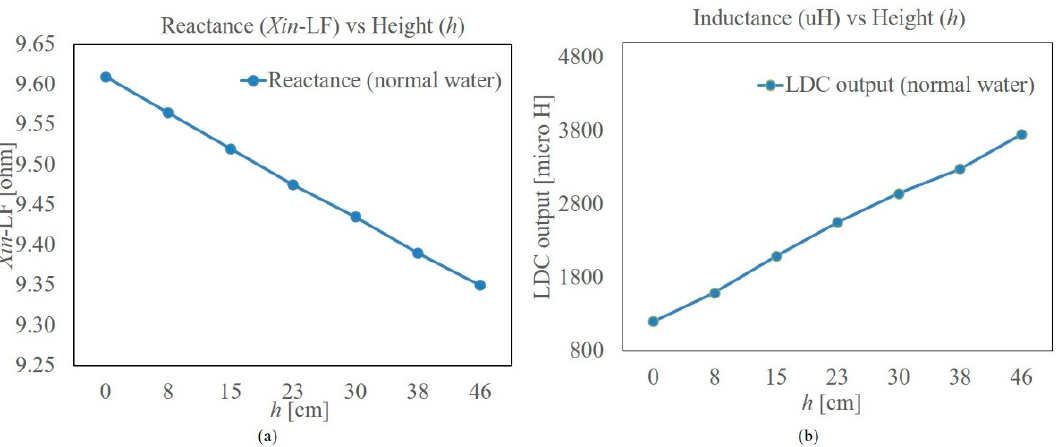
Figure 4. ( a ) Input reactance of the planar coil with respect to level ( h ) measured at 1 kHz. ( b ) Output from the LDC for the same water level.